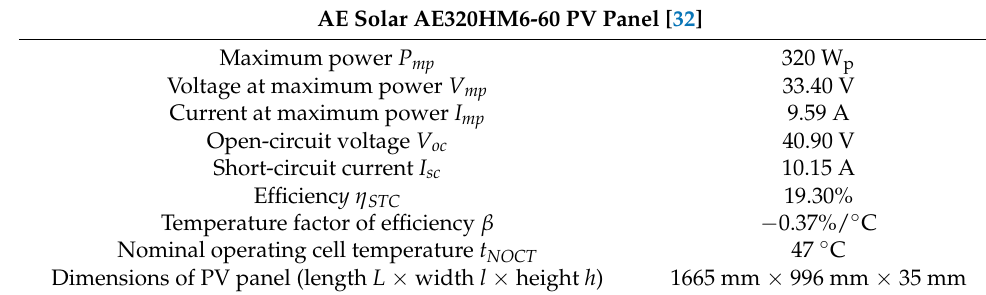
Table 1. The electrical and dimensional characteristics of the photovoltaic panel studied.